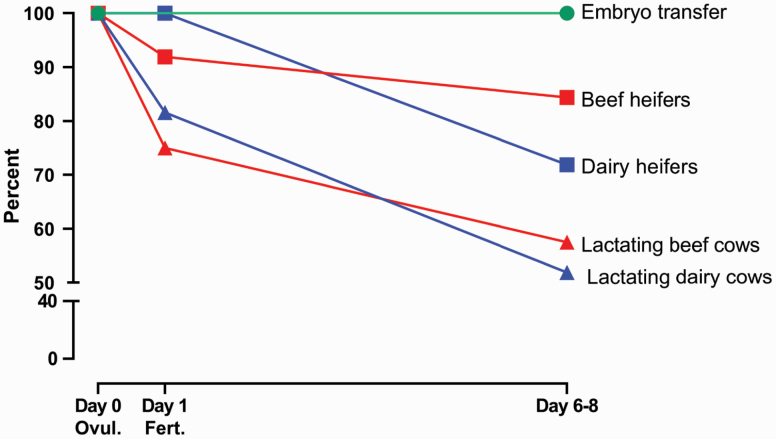
Effect of type of female and reproductive technique (ET using a fresh embryo vs. AI) on the percent of females eligible for pregnancy at ovulation (day 0) and percent pregnant at fertilization (day 1) and blastocyst formation (day 6 to 8). Data for beef heifers were calculated by summing results from two experiments (Carter et al., 2008; Diskin and Sreenan, 1980) and data for lactating dairy cows are from a compilation of studies by Wiltbank et al. (2016). Other sources of data were Sartori et al. (2002) for dairy heifers and Breuel et al. (1993) for lactating beef cows. Note that the estimate of 100% for pregnancy/ET assumes that only live embryos were transferred and that the embryo was correctly positioned during the transfer process. Values would be lower if some embryos transferred were dead or placed incorrectly.